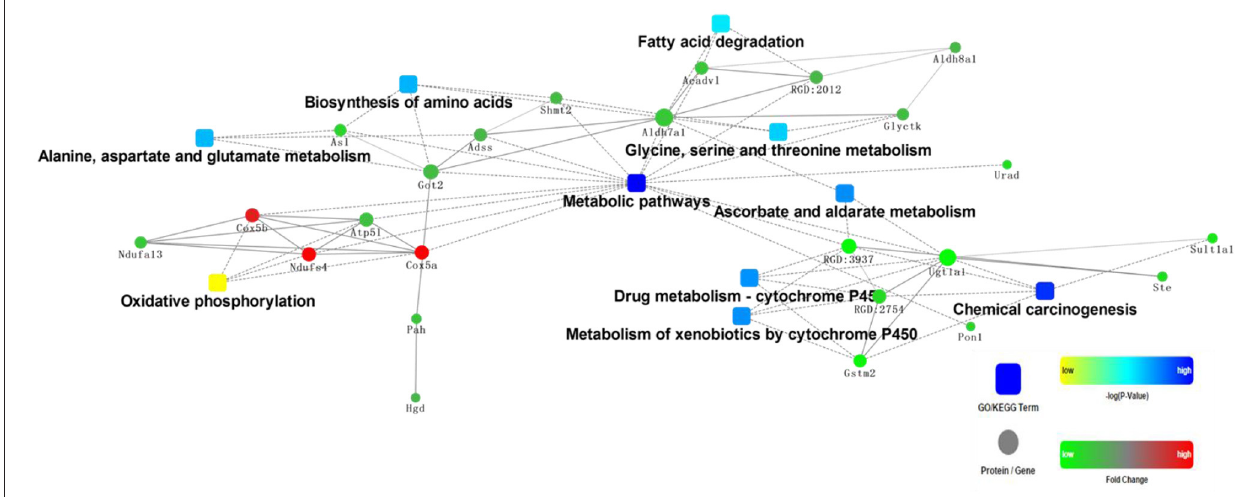
FIGURE 1 | Protein-protein interaction analysis of rat liver differentially expressed protein in chicken: casein. Squares are pathways, and dots are proteins. Yellow squares and green dots represent downregulation, while blue squares and red dots represent upregulation.